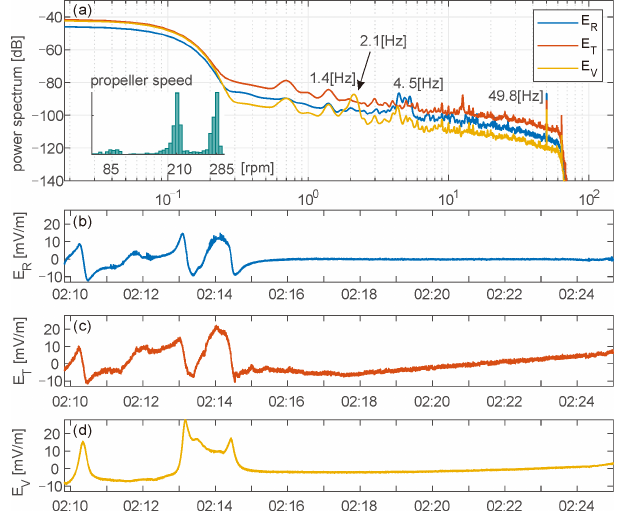
Figure 4. Time series of the three components of the electrical field and the frequency analysis of the recorded data. (a) Spectrum of the three components of the electrical field with the histogram of propeller speed. The frequency components of 1.4 and 3.5–4.5Hz are caused by the speed of propellers. The lower three panels show (b) the time series of the inline component E R , (c) the time series of the crossline component E T and (d) the time series of the vertical component E V